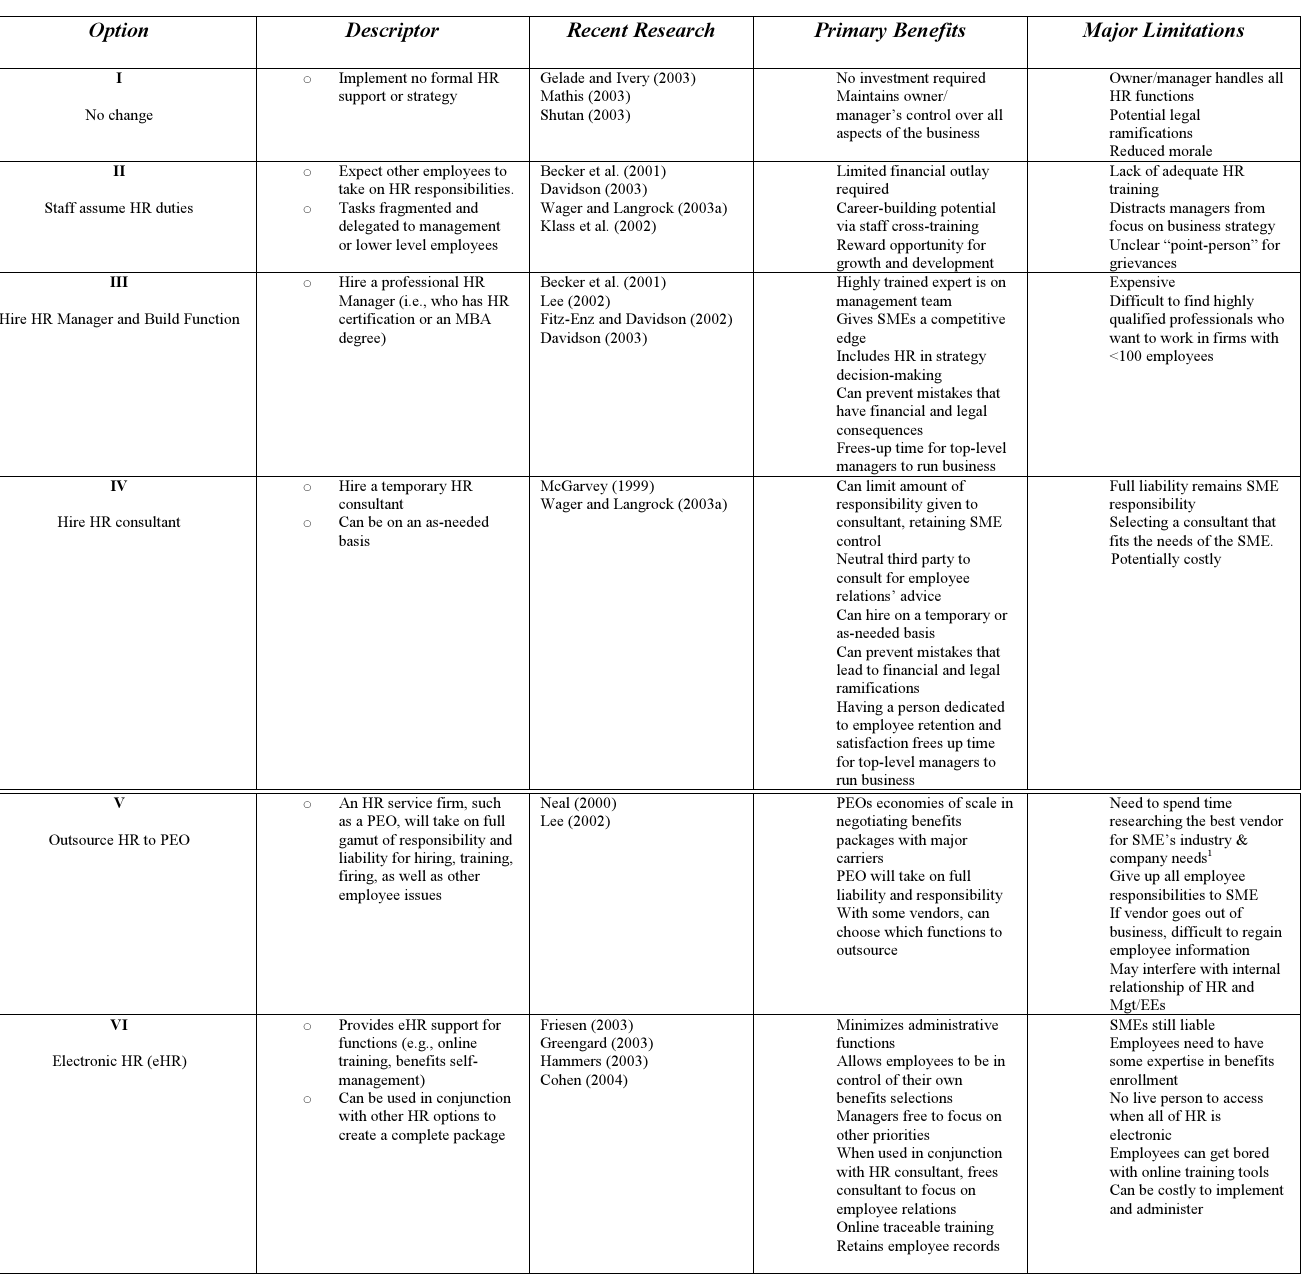
Table 1. Pros and Cons of HR Options for Small and Medium-Sized